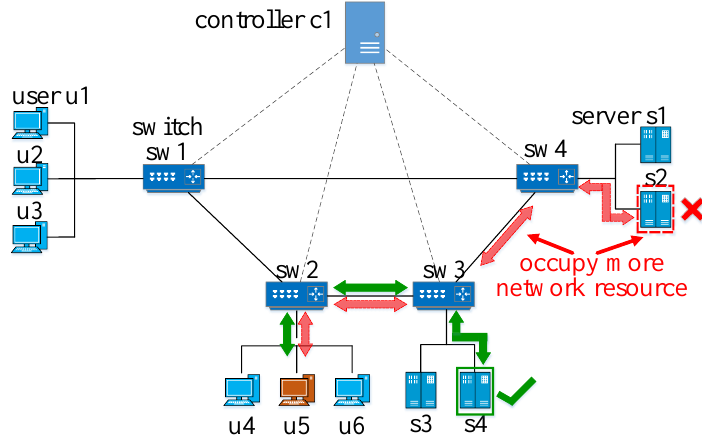
Figure 1. Example of the shortcoming caused by sequential server selection and routing path